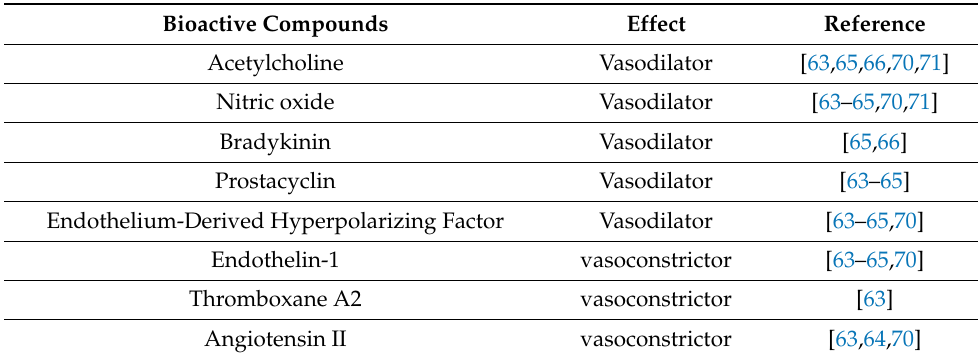
Table 1. Vasoactive factors that regulates vascular